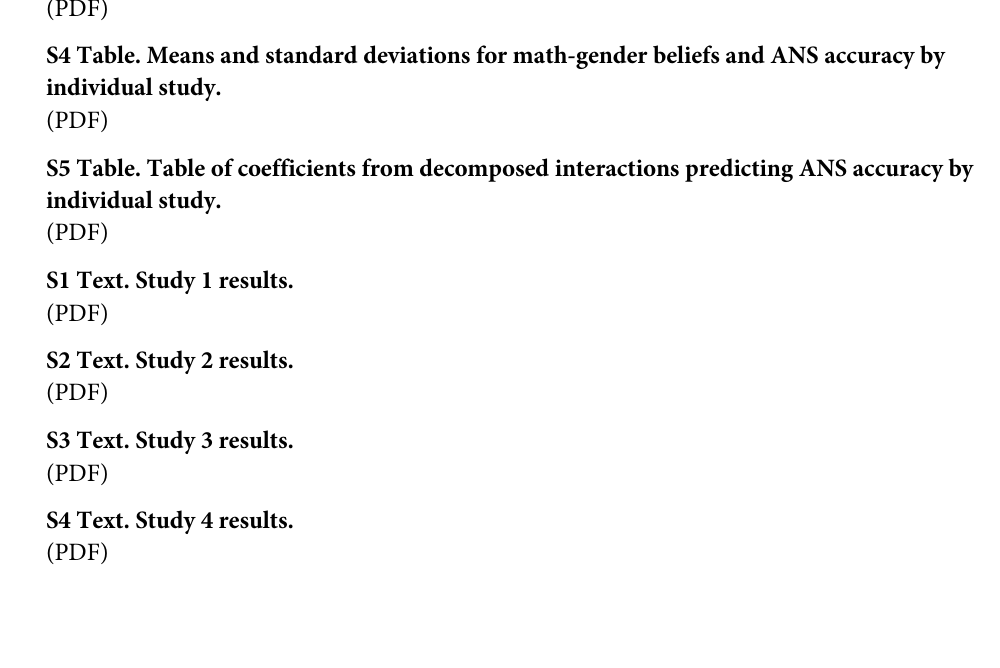
S2 Table. Means and standard deviations for math-gender beliefs and ANS accuracy. S3 Table. Table of coefficients from decomposed interactions predicting ANS accuracy by individual study. S4 Table. Means and standard deviations for math-gender beliefs and ANS accuracy by individual study. S5 Table. Table of coefficients from decomposed interactions predicting ANS accuracy by individual